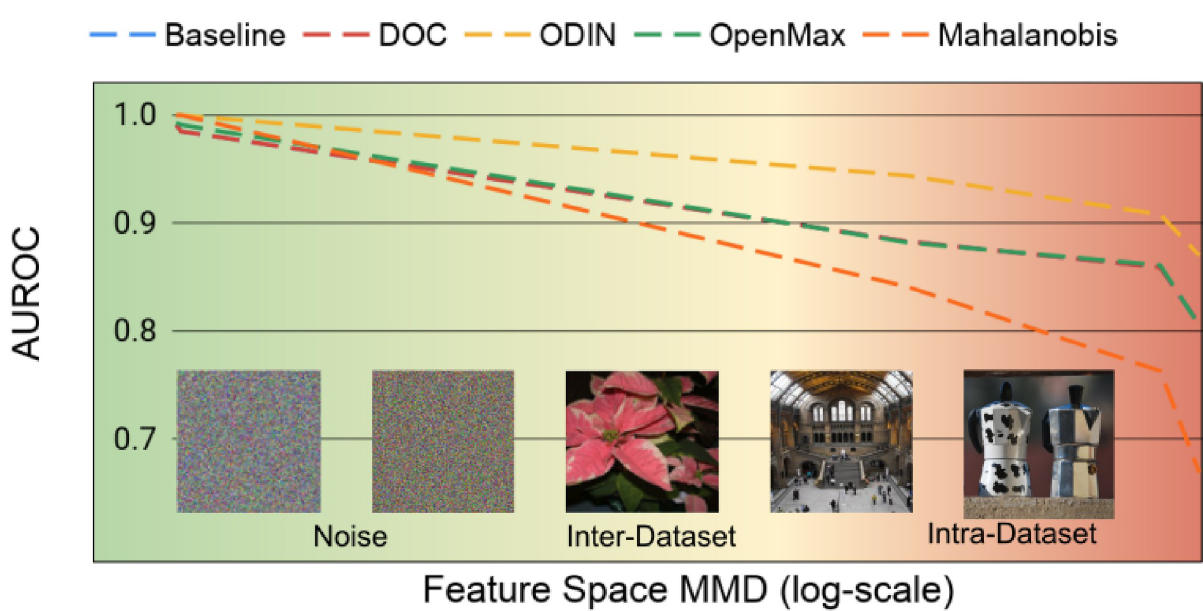
Fig 5. OOD similarity comparison. AUROC for OSC as a function of the MMD metric (log-scale, axis-reversed) measured from ResNet-18 embeddings for each dataset tested. For all methods tested, there is a large decrease in open set accuracy as the difference in feature representations of in-distribution and open set datasets